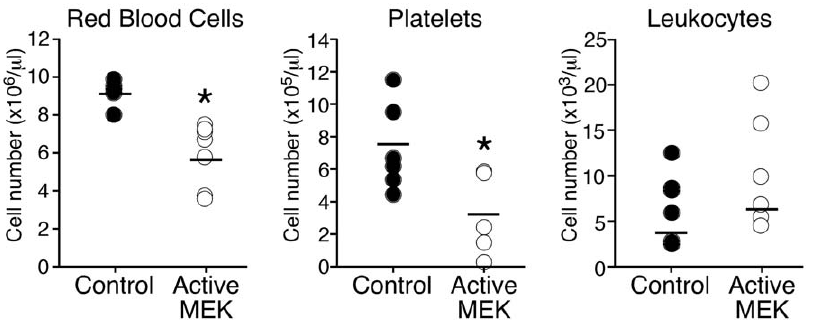
Figure 2. Dysfunctional hematopoiesis in terminally ill active MEK mice. Differential cell counting of blood was performed on peripheral blood harvested from control mice (filled circle, n=6) and active MEK mice (empty circle, n=6). Absolute cell counts were determined using a HemaVet machine. The horizontal bar denotes the mean value of each group. *, P , 0.05 (statistical significance) by Student t test.